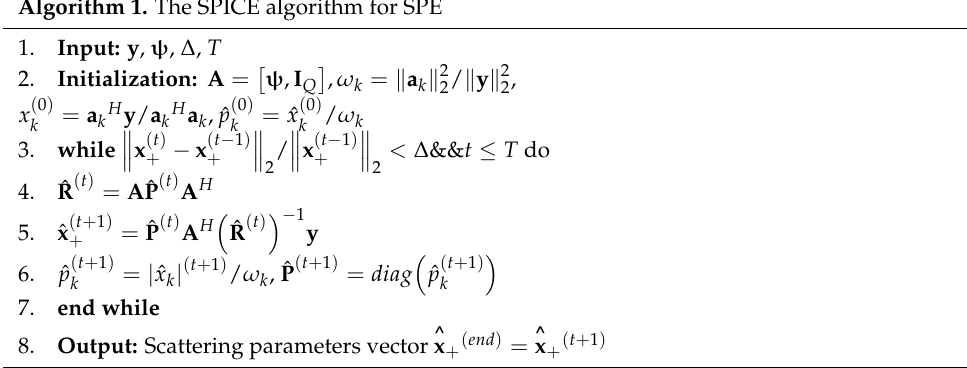
Algorithm 1. The SPICE algorithm for